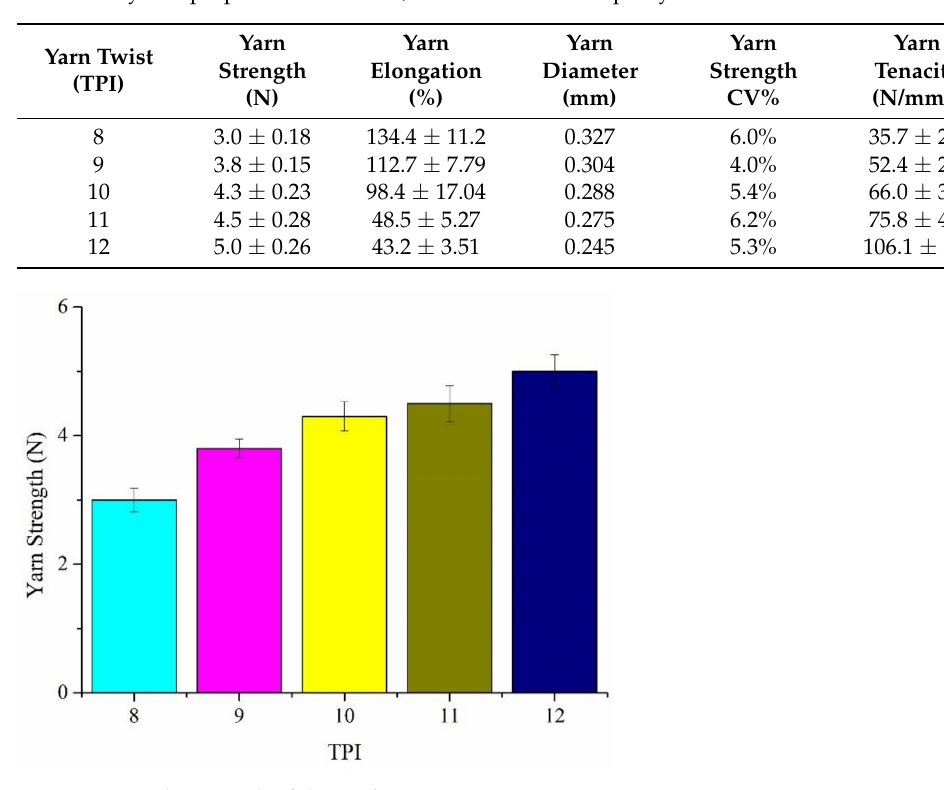
Table 1. Physical properties of Ge fiber/stainless steel core-spun yarns.